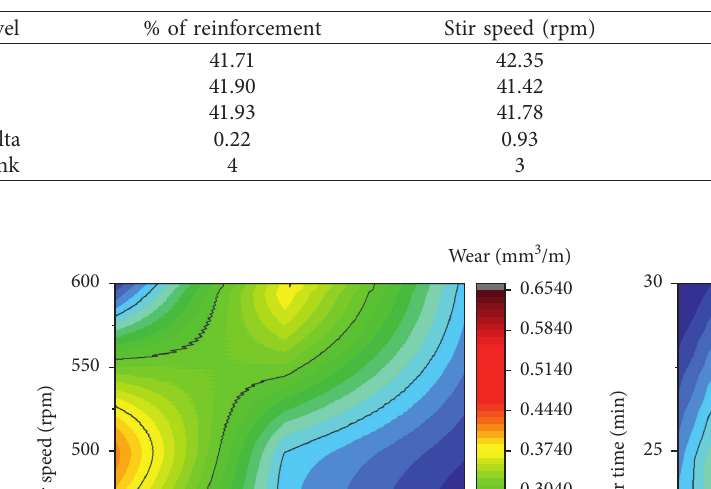
Table 8: Response table for signal-to-noise ratios (microhardness). Larger is better.